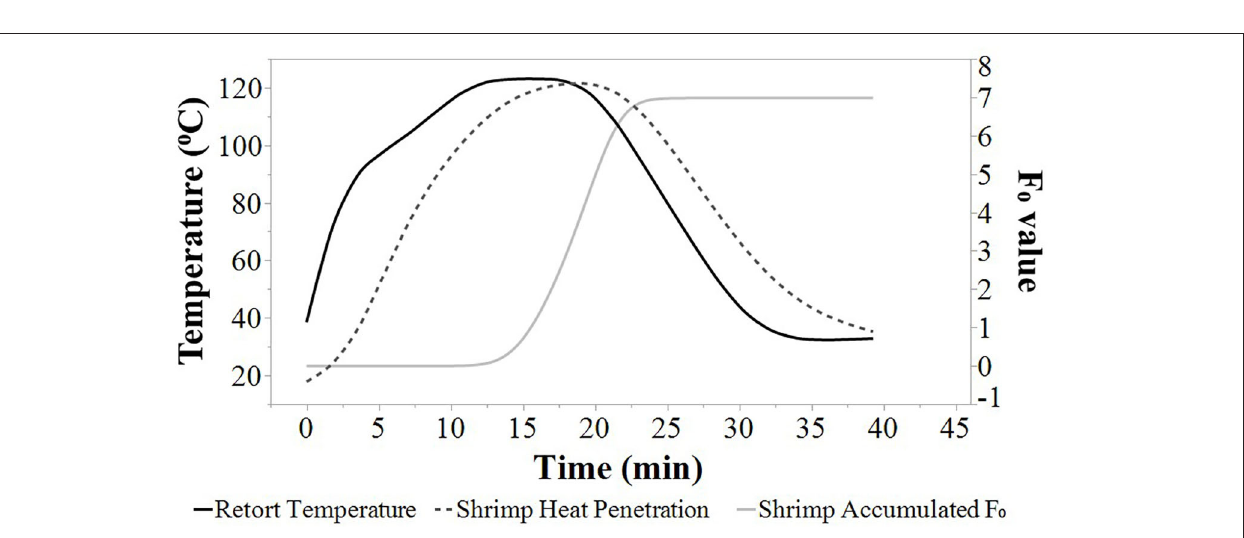
to compare Ball’s parameters at F 0 values of 6.0 and 3.5.